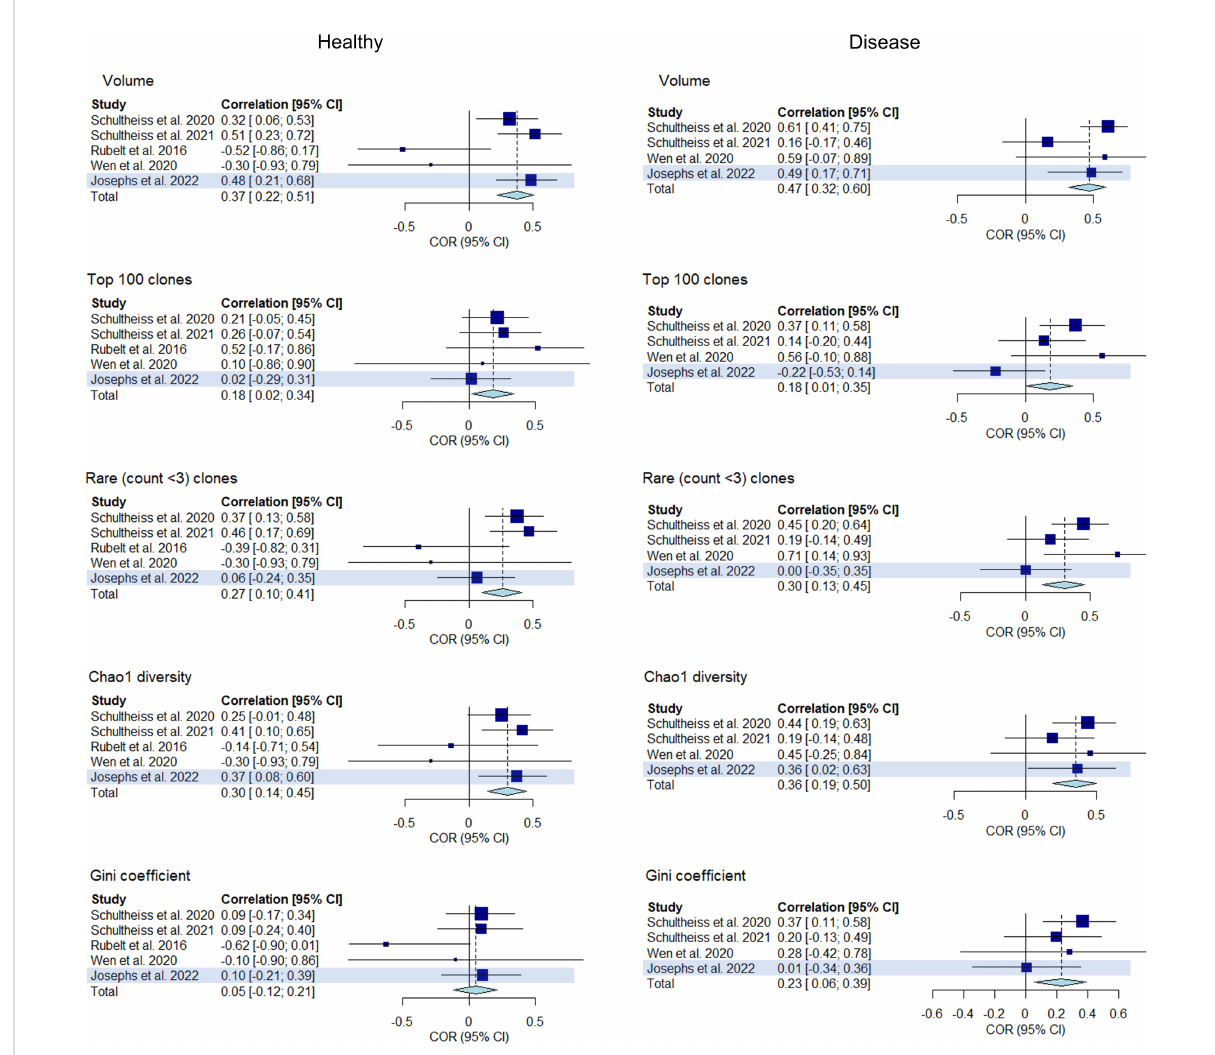
FIGURE 9 Forest plot of meta-analyses of clonality and diversity metrics with the replication study (using Josephs et al., 2022) included. Meta-analysis results of the correlations between clonality and diversity summary statistics derived from individual BCR and TCR repertoires from each study including the replication study (highlighted) are presented in a forest plot. Size of the squares indicate study weights that are proportional to sample size. Effect sizes are from a common effect